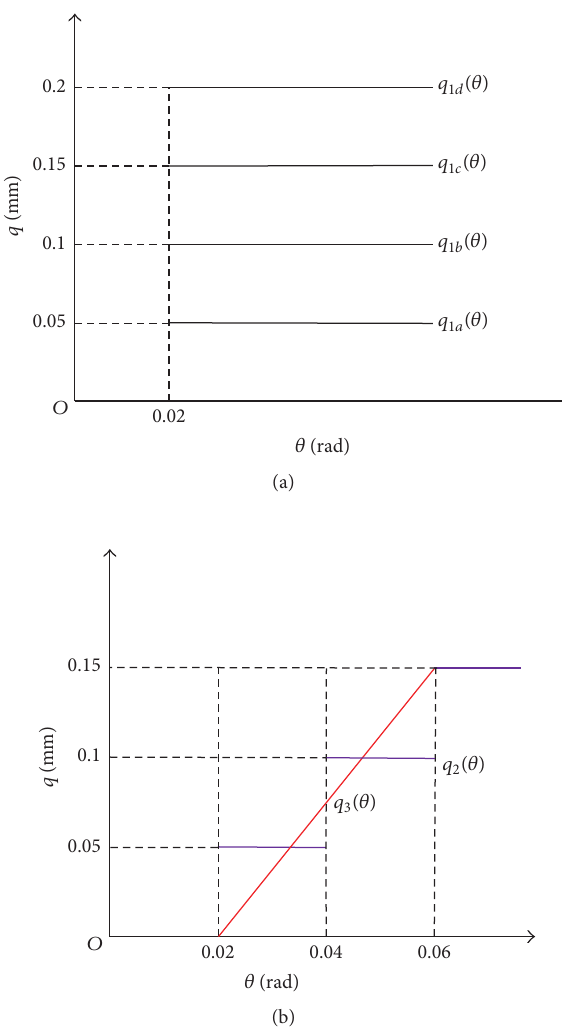
Figure 2: TPOC models. (a) Different propagation lengths with the same propagation model. (b) Different propagation models with the same propagation length.